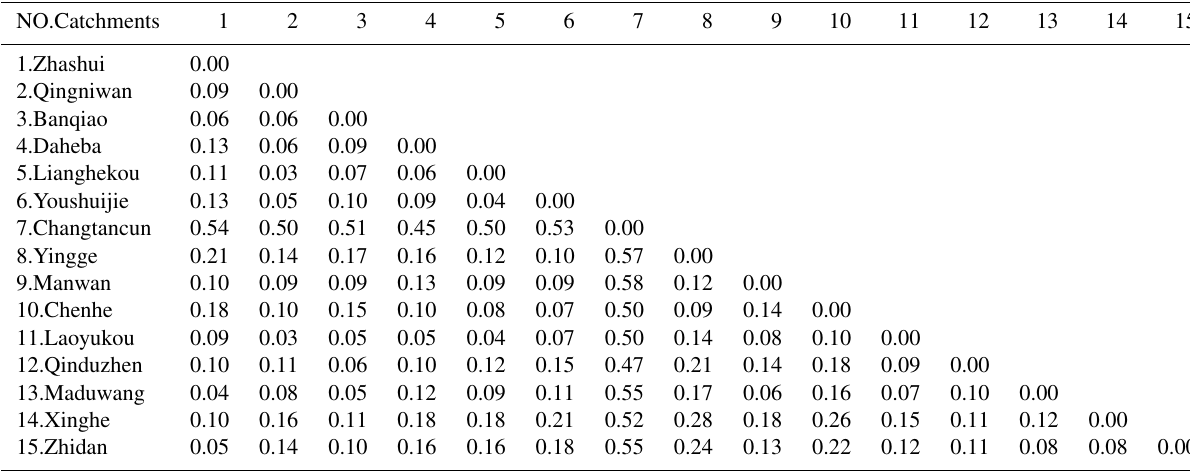
Table 2. Root mean square errors between catchments.